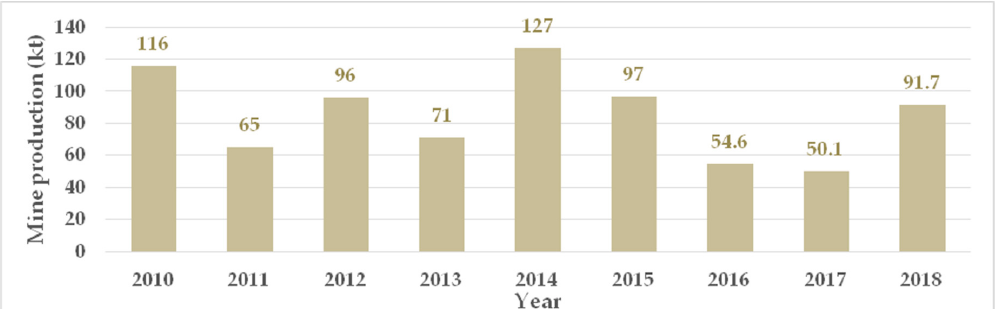
Figure 4. The high purity limestone extraction 2010–2018 in kilotons (kt).